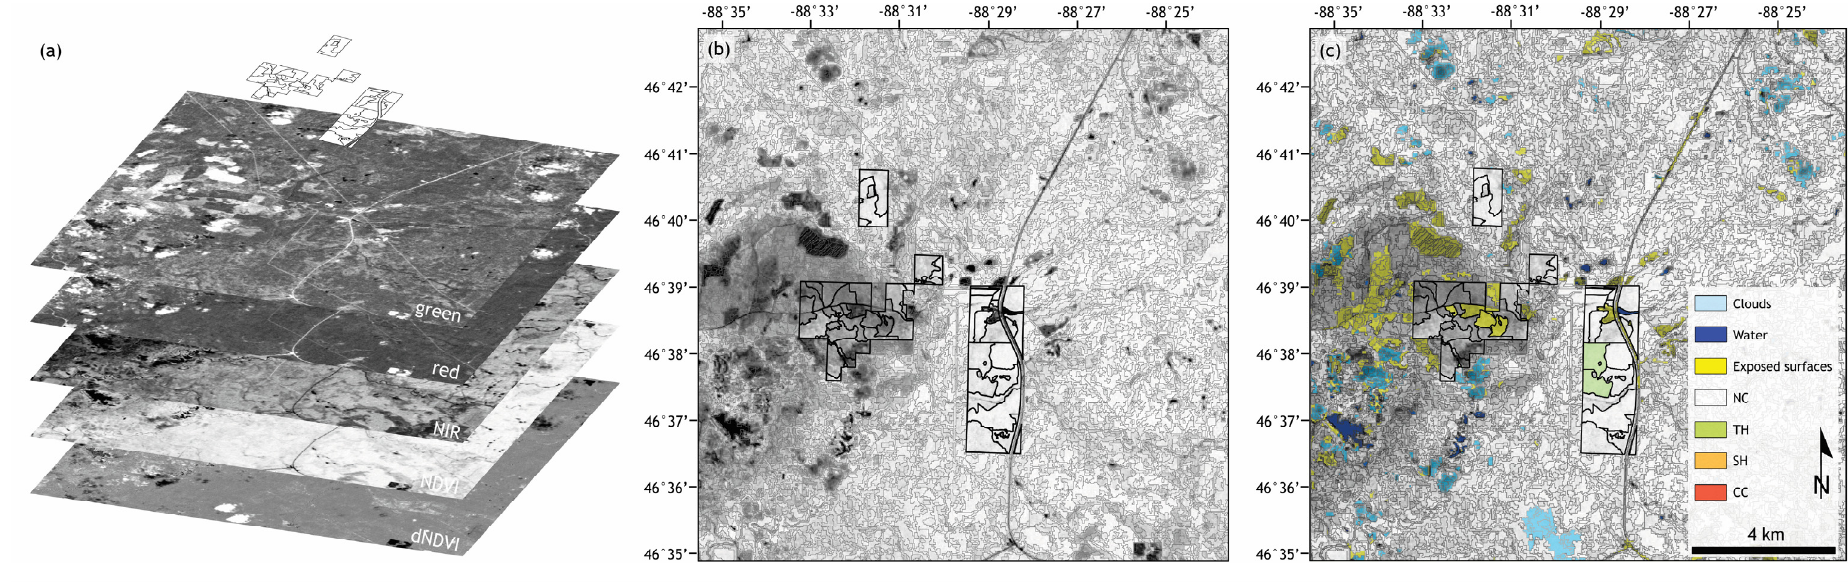
Figure 2. Example of OBCD analysis of the 33 management units at the FFC and the surrounding area on the 2005 scene: ( a ) Input layers; ( b ) segments (gray) and unit boundaries (black); and ( c ) classification with